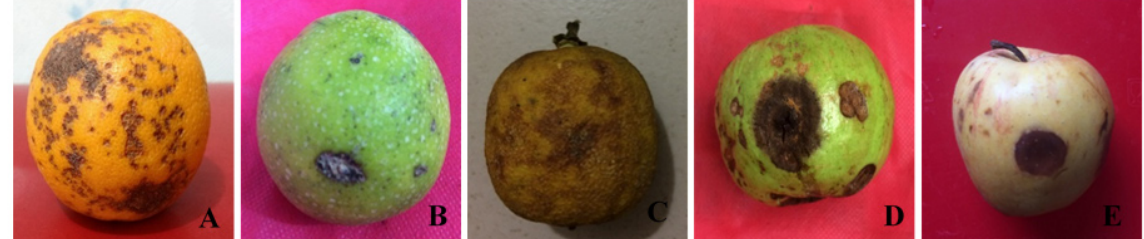
Figure 3. Naturally infected and artificially inoculated fruit showing symptoms of bacterial black rot. ( A ) post-harvest natural infection, ( B ) malta (BS1), ( C ) lemon (BS1), ( D ) guava (BS2), and ( E ) apple (BS2) (artificially inoculated four fruits); images taken 10 days after inoculation.